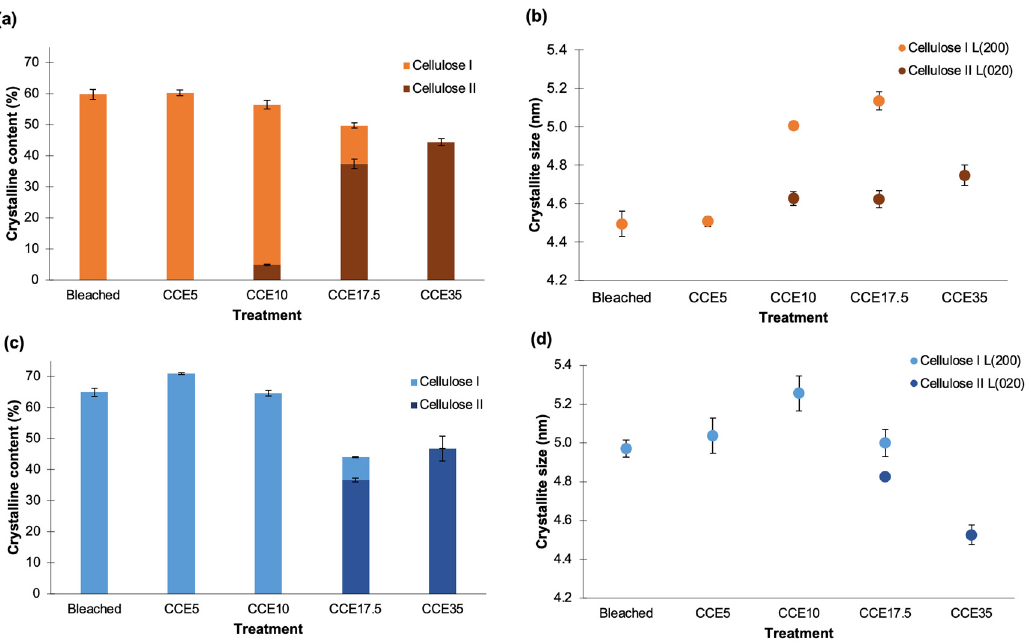
Figure 5. Crystalline structure of cellulose. ( a,c ) Crystallinity and ( b,d ) crystallite size for eucalyptus and pine pulps, respectively. Different colors in bars indicated proportions of cellulose I and II in samples.